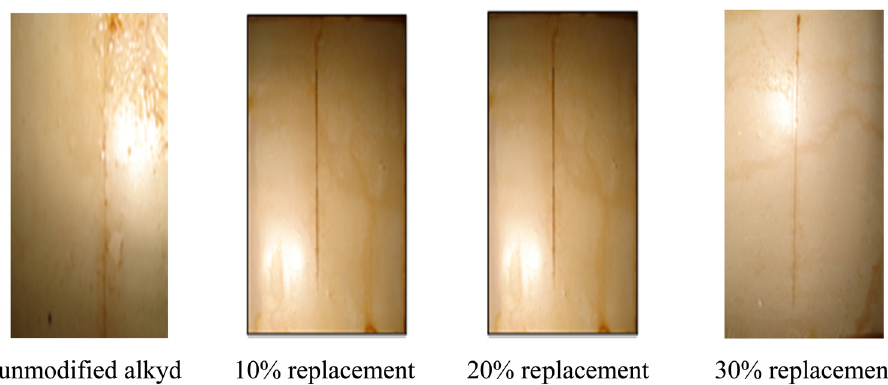
Figure 6: The photographic of painted steel samples exposed to salt spray based on modi fi cation by using 1,3,5 - tris -( 2 - hydroxyethyl ) cyanuric acid and for unmodi fi ed alkyd resin.